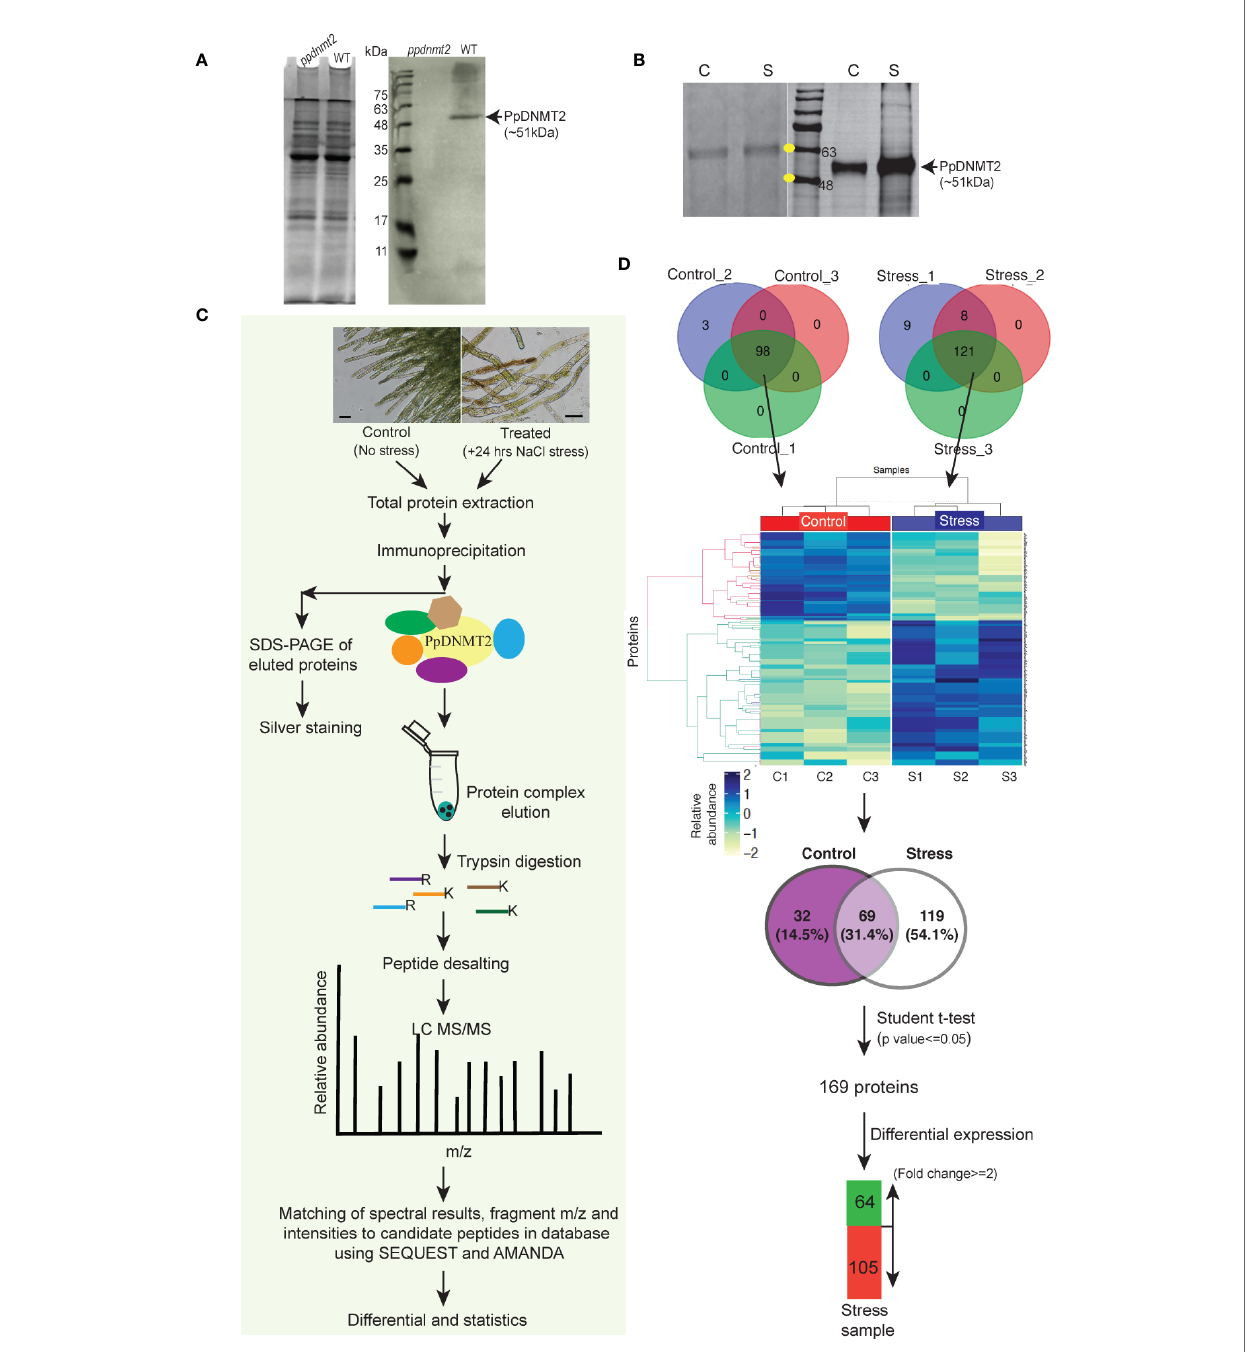
FIGURE 7 | (A) (Left) Coomassie stained image of polyacrylamide gel showing fractionation of equal amounts of total protein (50 µg each) extracted from ppdnmt2 and wild type protonema tissue. (Right) Western blot probed with PpDNMT2-speci fi c antibody showing presence of PpDNMT2 protein band of expected size in wild type plants and its absence in ppdnmt2 . (B) (Left) Silver stained image of polyacrylamide gel showing proteins isolated from control (C, 0 h) and stress-treated, (S) protonema tissue. (Right) Immunoblot of proteins probed with PpDNMT2-speci fi c antibody. Arrow points to the band position of ~51 kDa PpDNMT2, and the yellow dots on the marker bands in the protein ladder indicate 48 and 63 kDa proteins, respectively. (C) Outline of steps followed to immunoprecipitate proteins in complex with PpDNMT2 followed by their identi fi cation by LC-MS/MS. Scale bar = 50 µm. (D) Summary of analyzed data. Venn diagram on top shows number of proteins identi fi ed in each of the three biological replicates of control and stress samples. Distribution of these proteins in both samples before and after application of Student t-test. Heat map showing differential abundance of 169 proteins in the Control (C1 – C3) and Stress (S1 – S3) samples. For generating heat map abundance, values were log2 transformed and z-normalized. Hierarchical clustering was then performed using Euclidian distance and average linkage using in-House R script (Package: ComplexHeatmap). Pale yellow and blue colors, respectively, represent low and high protein